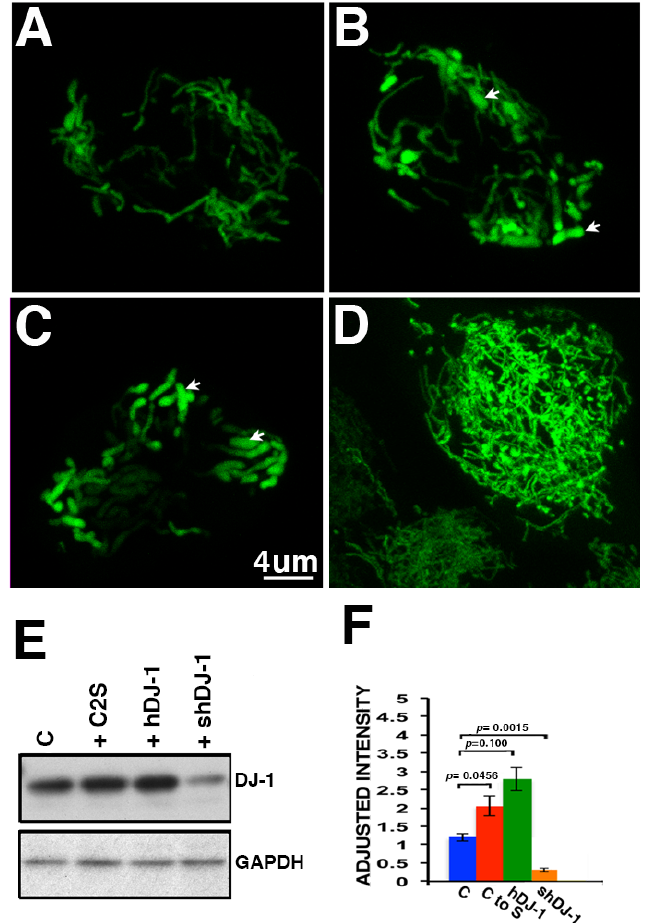
Figure 5. Transduction of hfRPE monolayers with the DJ-1 adenoviruses and lentiviruses and mitochondria morphology. Representative images of hfRPE monolayers transduced with ( A ) the control (Ad), ( B ) the human DJ-1 (hDJ-1), ( C ) human DJ-1 with the cysteine at residues 46, 53, and 106 mutated to serine (C2S), and ( D ) human shPARK followed by infection with CellLight ® Mito-GFP (green); arrows = dilated tubules. ( E ) Western blot analysis of lysates of the same cells reacted with DJ ‐ 1 and GAPDH antibodies. ( F ) Quantification of DJ ‐ 1 immunoreactivity ± SEM, n = 3. Bar = 4 μ m.